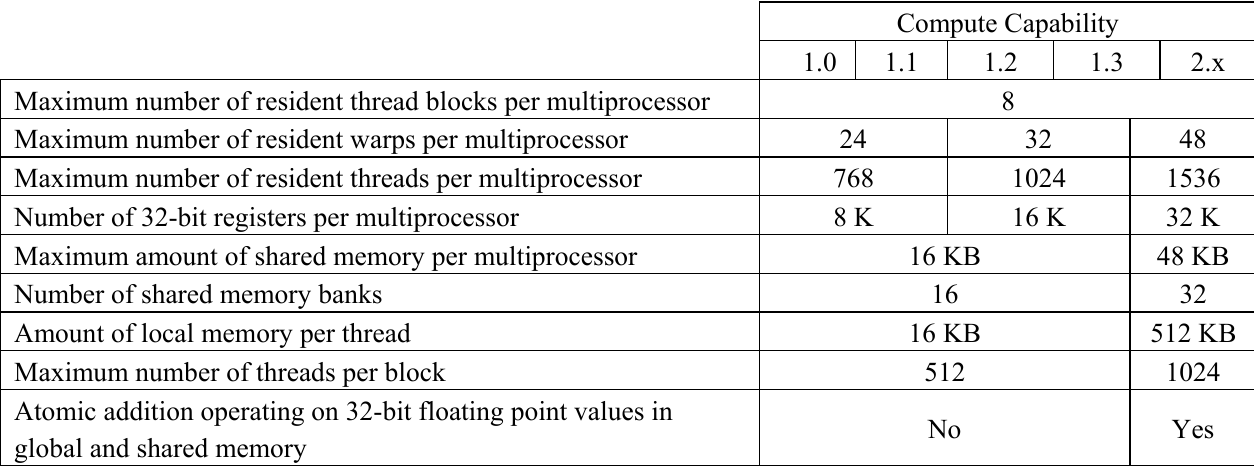
Table 3. Technical specifications and feature support per compute capability (Selected from Tables F-1 and F-2 of